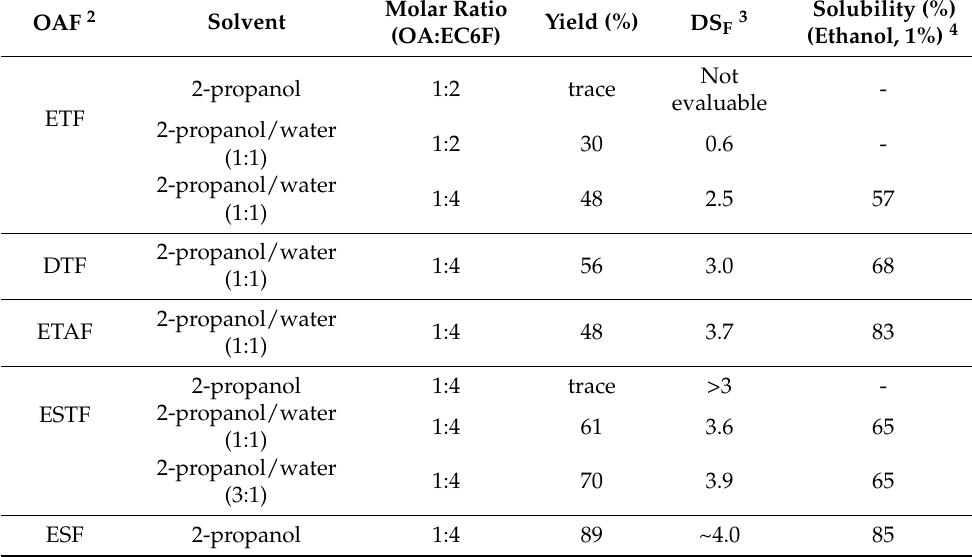
Table 4. Synthesis of fluorinated oligoamides 1